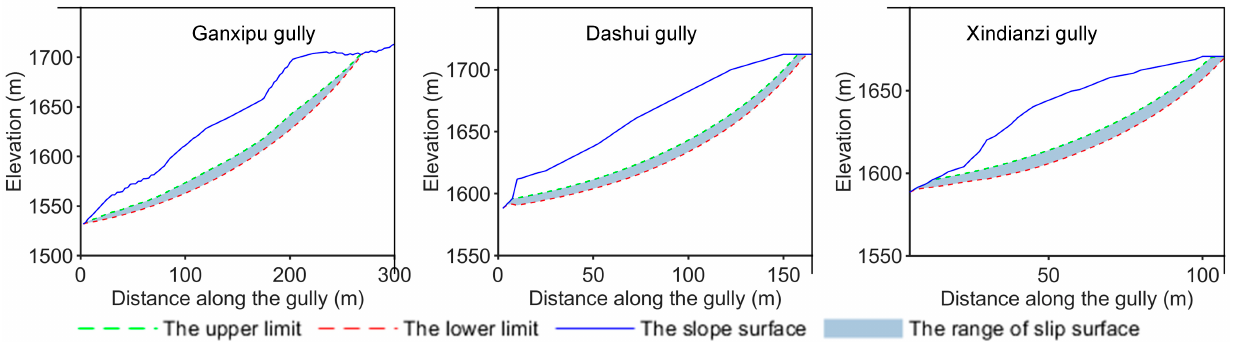
Figure 7. The predicted range of the critical slip surface in the source